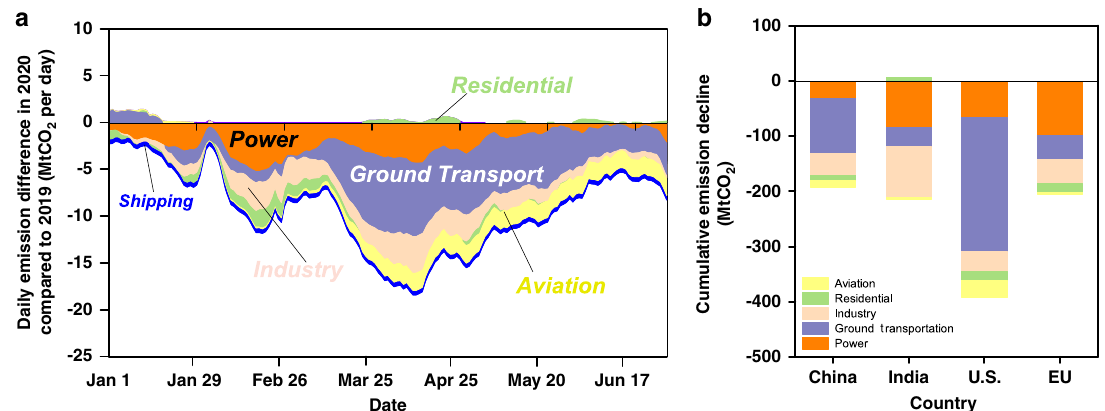
Fig. 3 Sectoral effects of COVID-19 on CO 2 emissions. a Sector-speci fi c effects of the COVID-19 pandemic on CO 2 emissions globally, shown as the 7-day running mean of daily differences between January 1st and June 30th of 2019 and 2020, and b the cumulative decline by sectors in each of China, India, U.S., and EU27 & UK in the fi rst half year